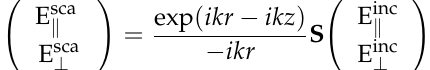
→ r is outside the μ ε (cid:48) → , and permeability and the point r is inside 0 ε μ , and permeability . 1 0